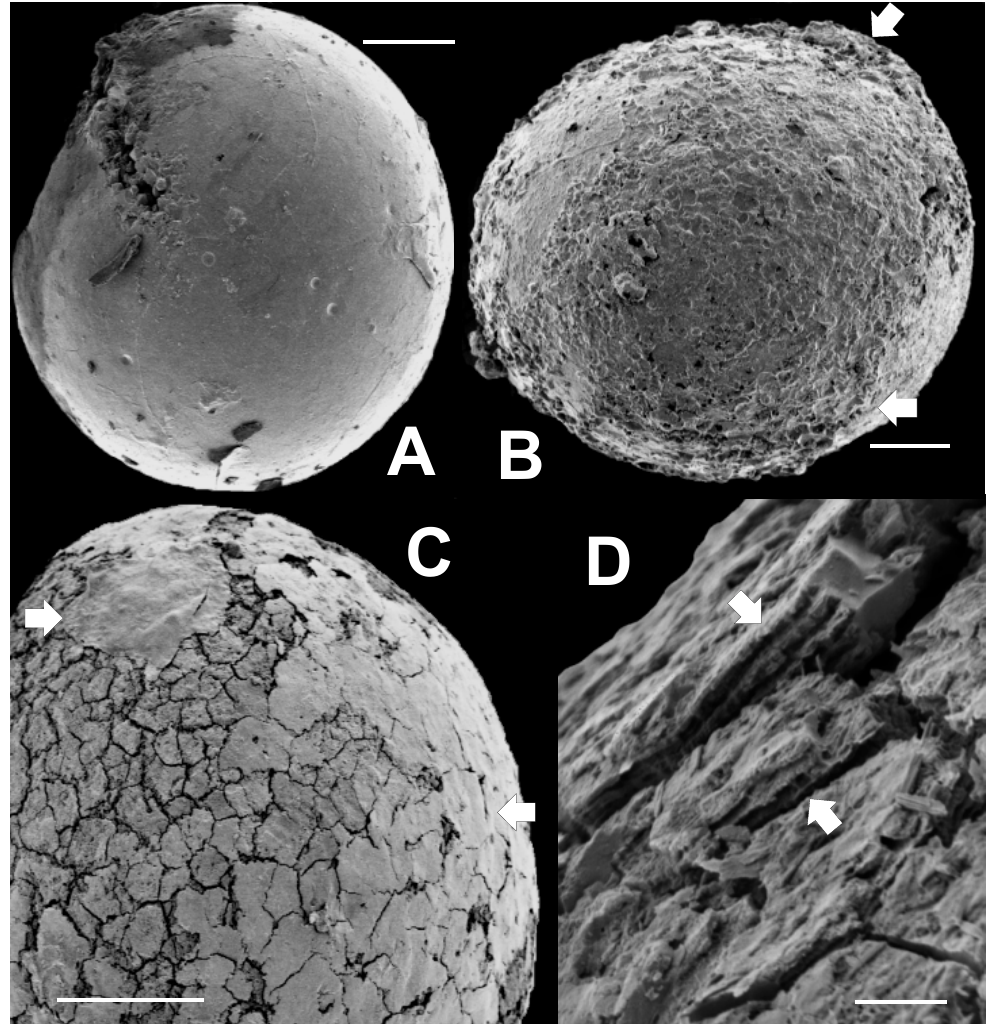
Figure 7. SEM images of non-spinose, sphaeromorphic pyritized microalgae extracted from rock matrix. Scale bar in A, B, and C = 50 µm. Scale bar in D = 5 µm. ( A ) specimen (TYS-14) with smooth surface split open in upper left; ( B ) specimen (TYS-02) with smooth surface covering small portions or upper right and lower left quadrants. White arrows indicate locations where smooth regions overlie the roughened area at the center of the specimen; ( C ) specimen (TYS-23) with a surface composed of pseudopolygonal “tiles” overlain in upper left (white arrow) by a thin, smooth, fine-grained covering. This covering becomes progressively broken into tiles toward the lower right (white arrow); ( D ) Close-up of tiled surface of TYS-23 in cross-section showing that this surface consists of several thin parallel layers 1 to 2 µm thick. In places, (white arrows) narrow, columnar or pillar-like structures extend between the layers.